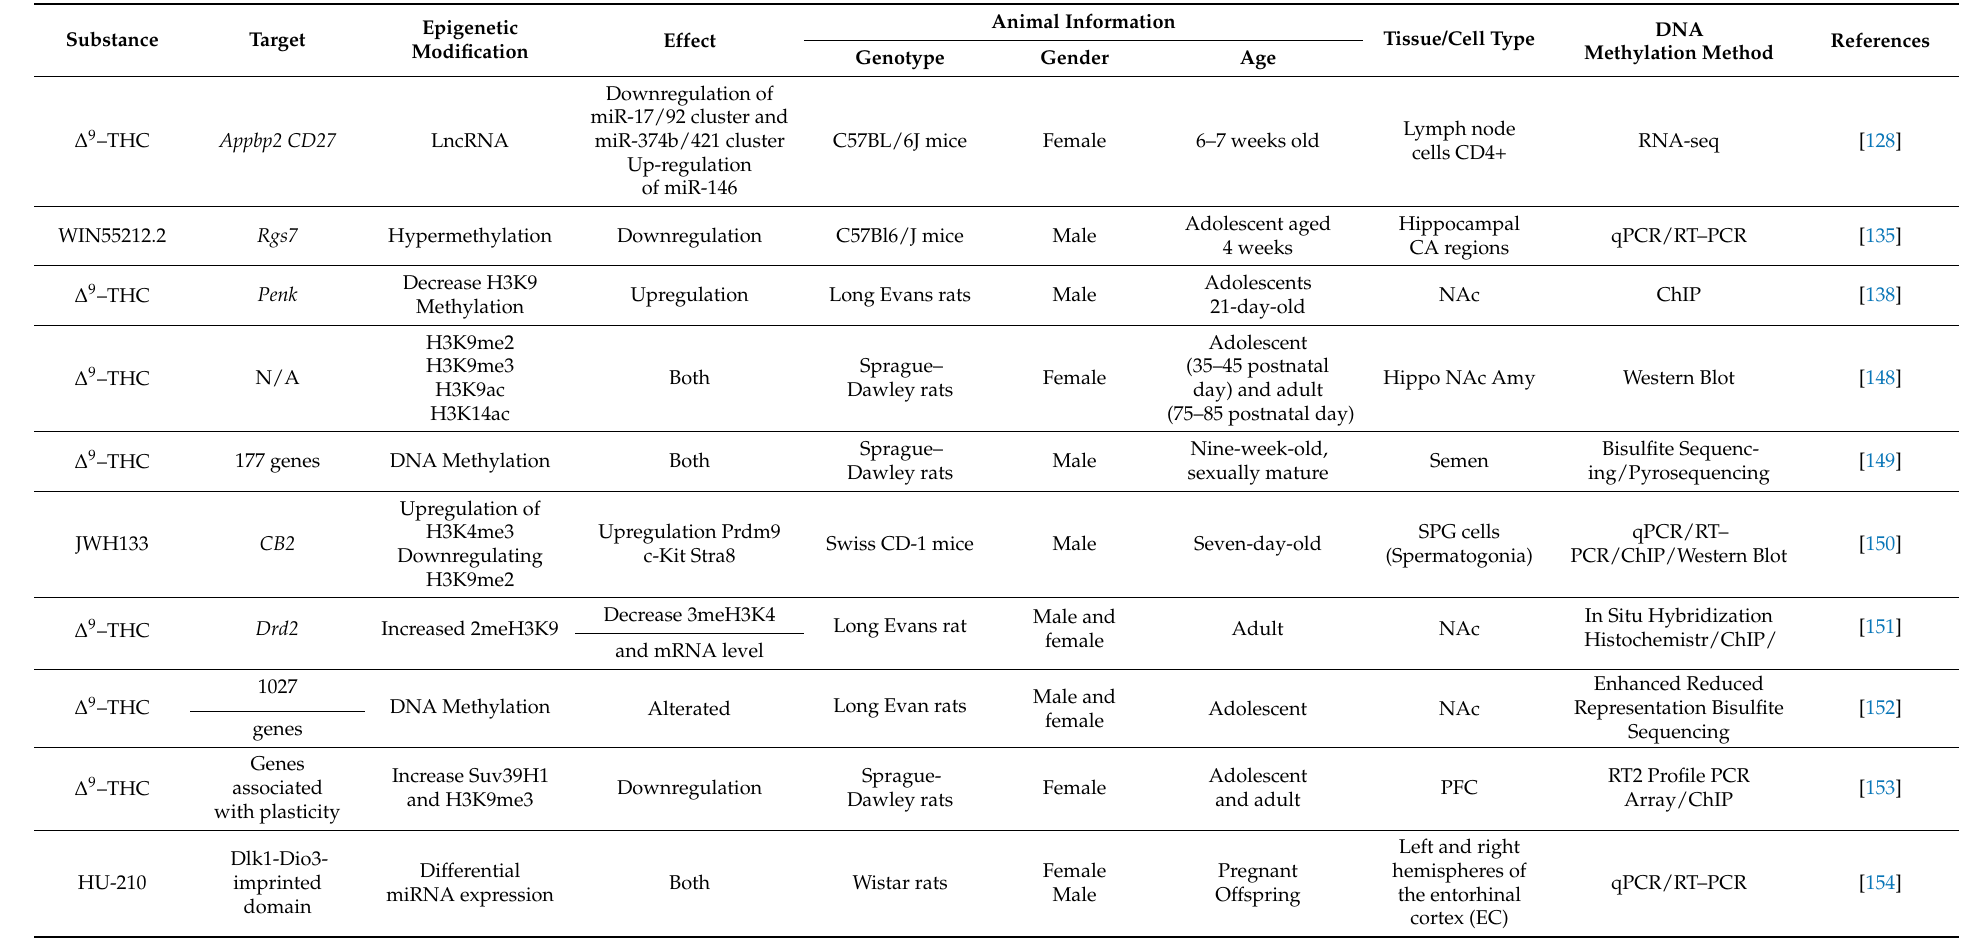
Table 3. Summarize of information obtained from the available literature about the main epigenetic changes observed in rodents after intake of traditional and new synthetic cannabinoids. We reported: the substances, the effects found after epigenetic modification, information on the animal model used (by specifying genotype, gender and age), and which detection method is the most appropriate to identify the previously highlighted epigenetic